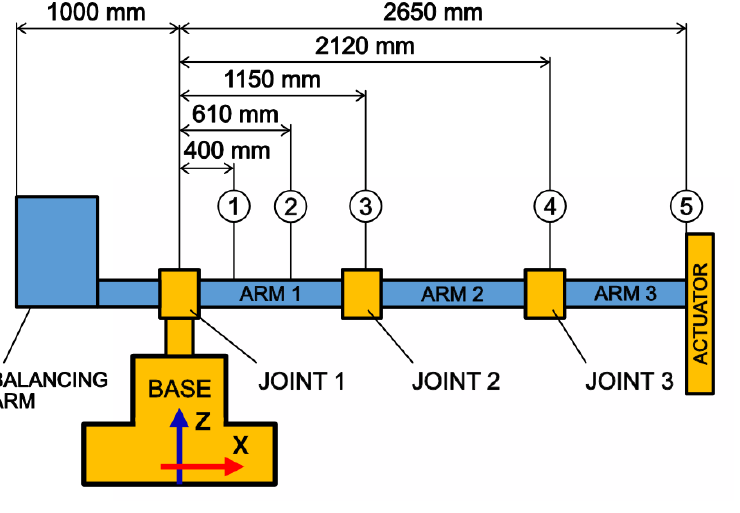
Figure 3. Diagram of the robotic arm with marked measurement